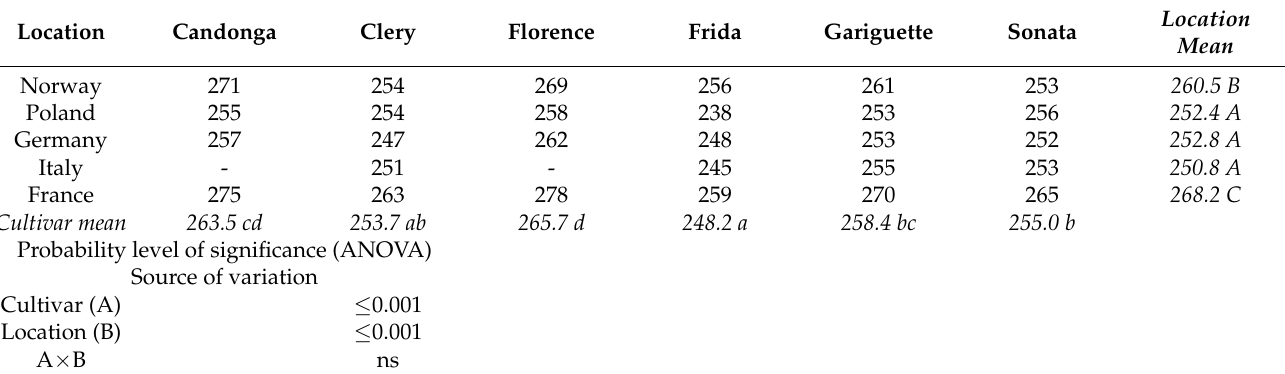
Table A2. Day of the year for strawberry floral development (Stage 2) as a mean of 3 years for six cultivars and five locations in